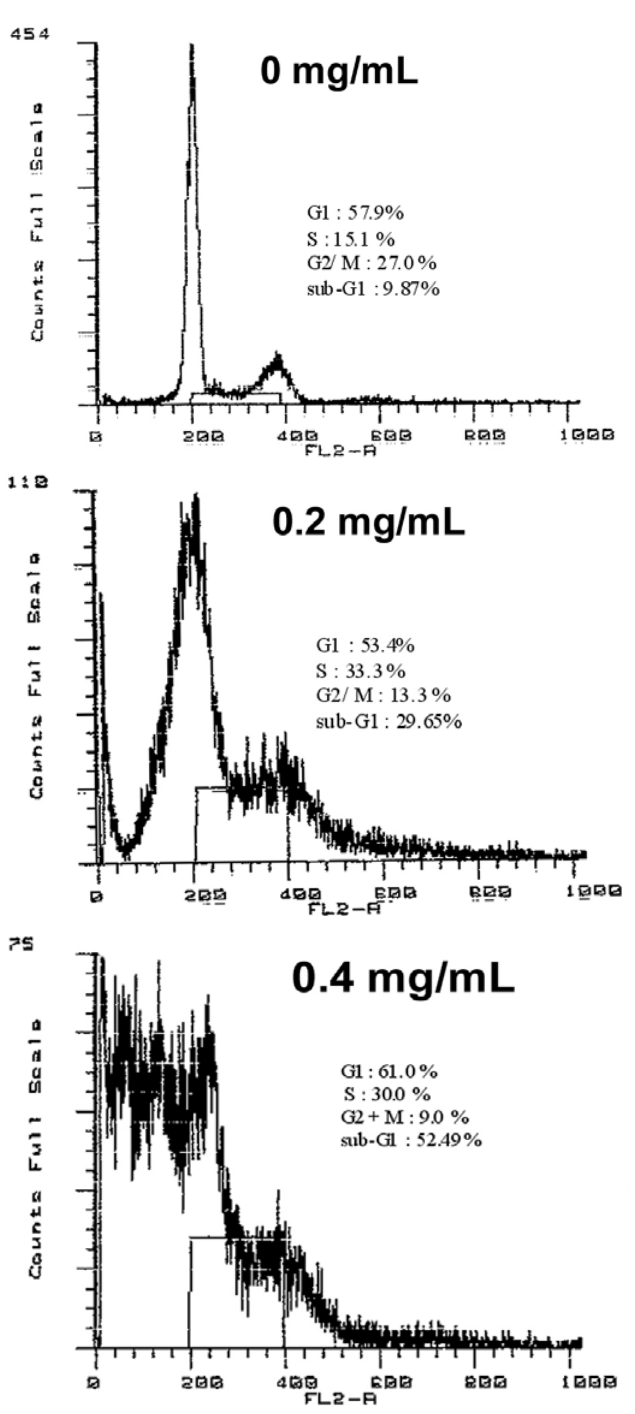
Figure 2. Effect of the essential oil of Cryptomeria japonica on cell cycle phase distribution in KB cells. KB cells were treated for 12 h with 0.2 and 0.4 mg/mL of the essential oil. Following the treatment, cells were collected for three different experiments examining apoptosis induction. The percentages of apoptotic cells were determined by propidium iodide staining followed by flow cytometric analysis. Data are representative of at least three independent